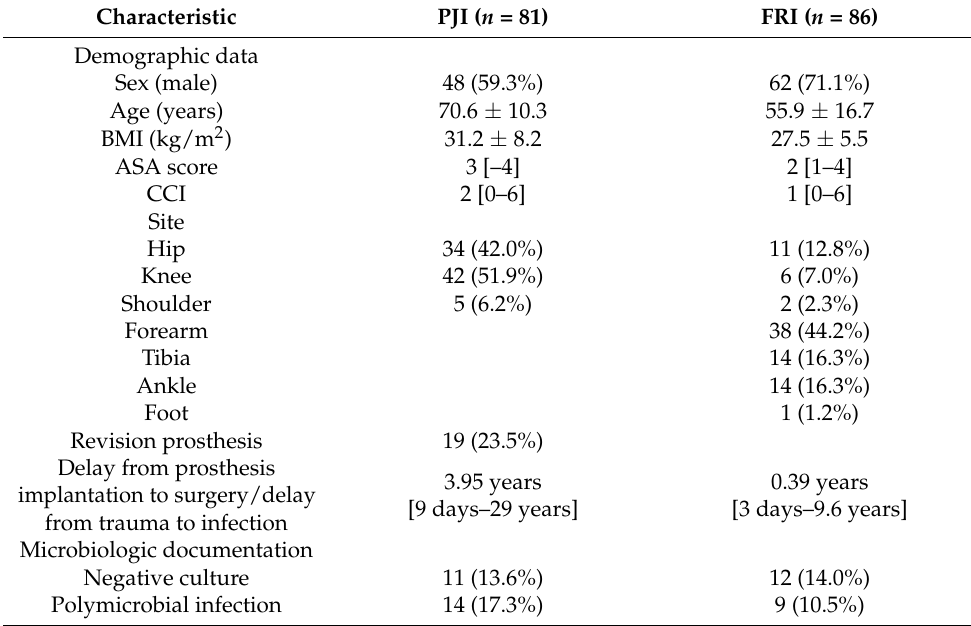
Table 1. Baseline characteristics of the cohorts consisting of PJI and FRI